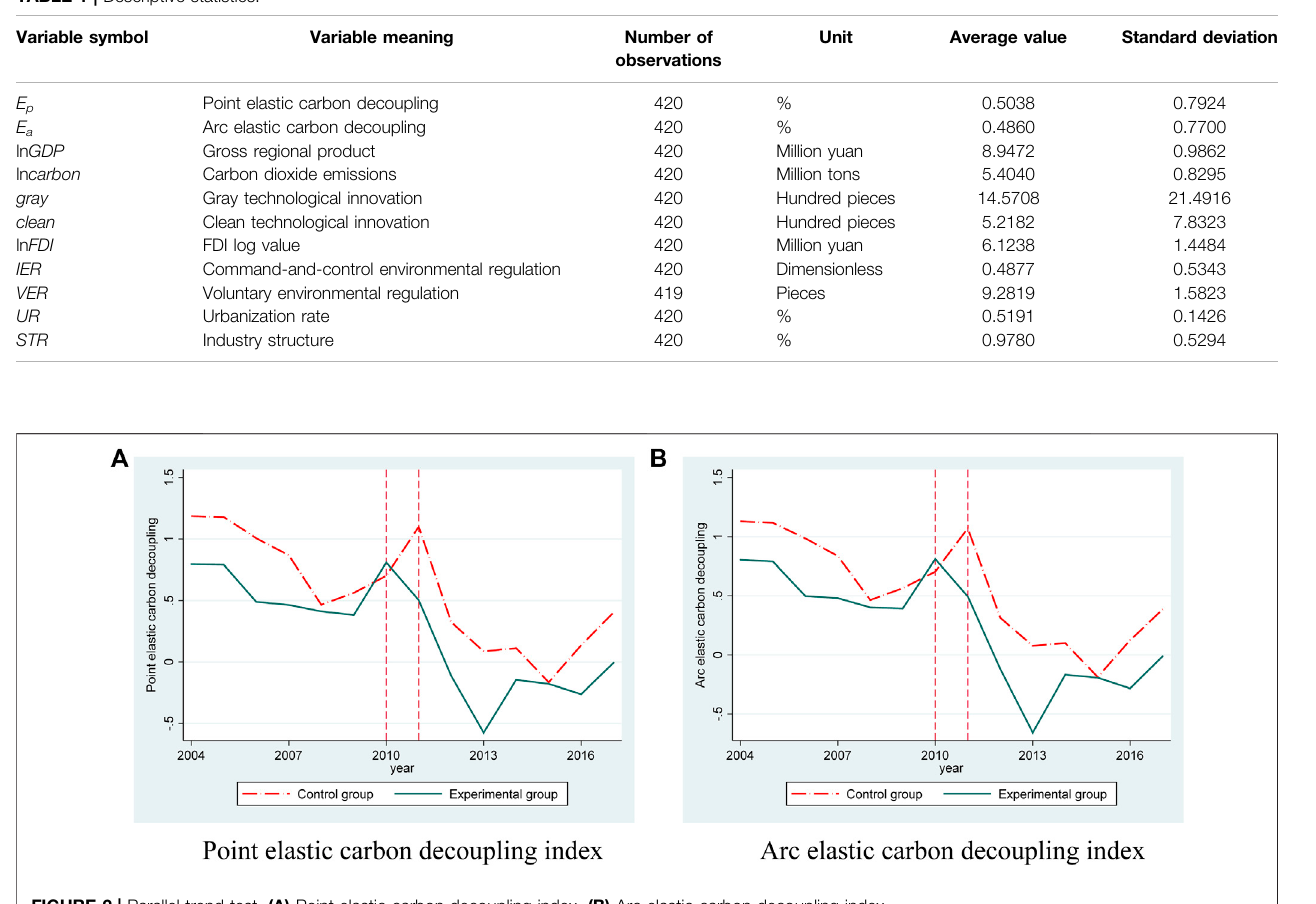
FIGURE 2 | Parallel trend test. (A) Point elastic carbon decoupling index. (B) Arc elastic carbon decoupling